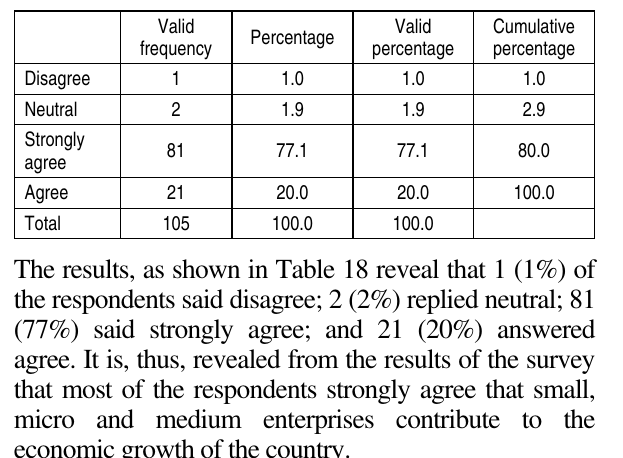
Table 18. Issue of growth of the SMME industry